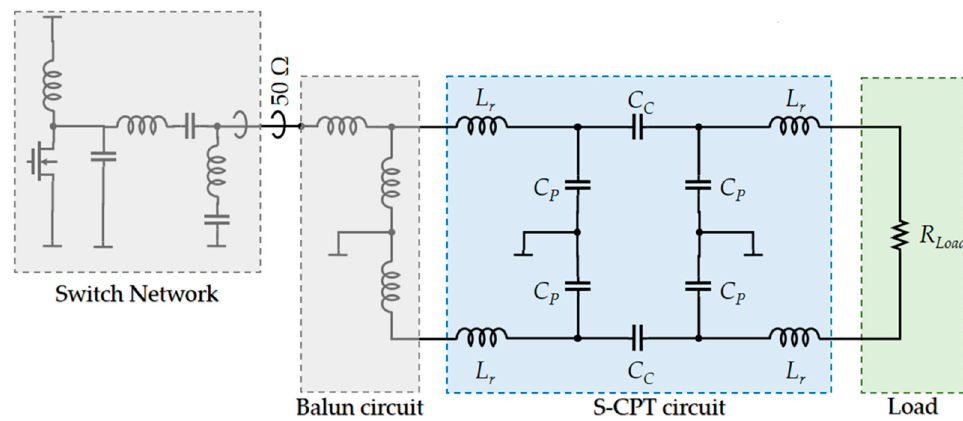
Figure 2. Circuit model of the complete shielded-CPT system.